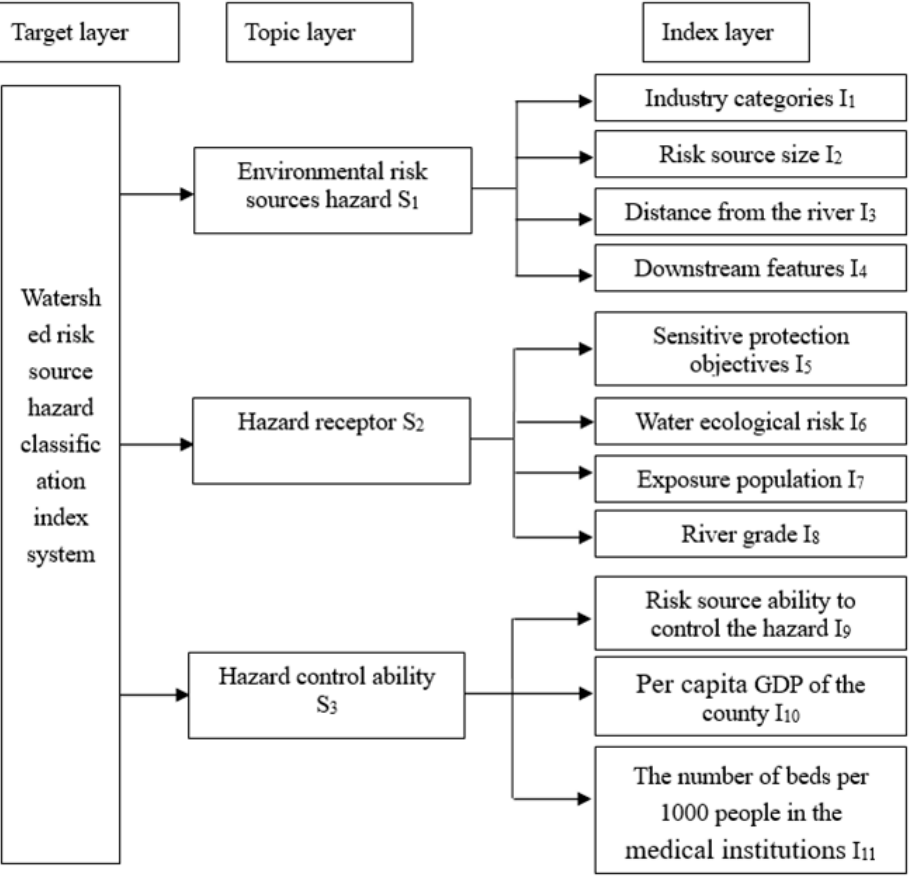
Figure 5. Risk source hazard index system.